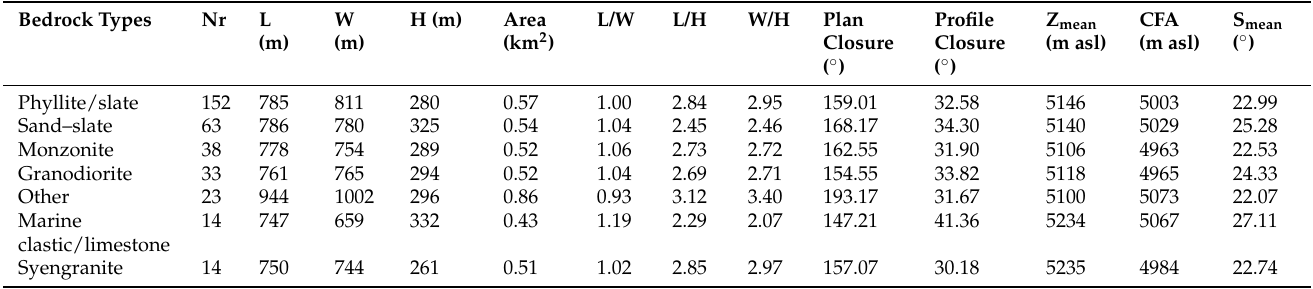
Table 5. Cirque metrics against bedrock types a